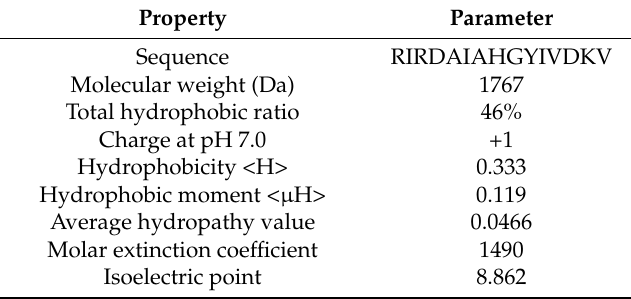
Table 1. Predicted physicochemical properties of peptide B11.